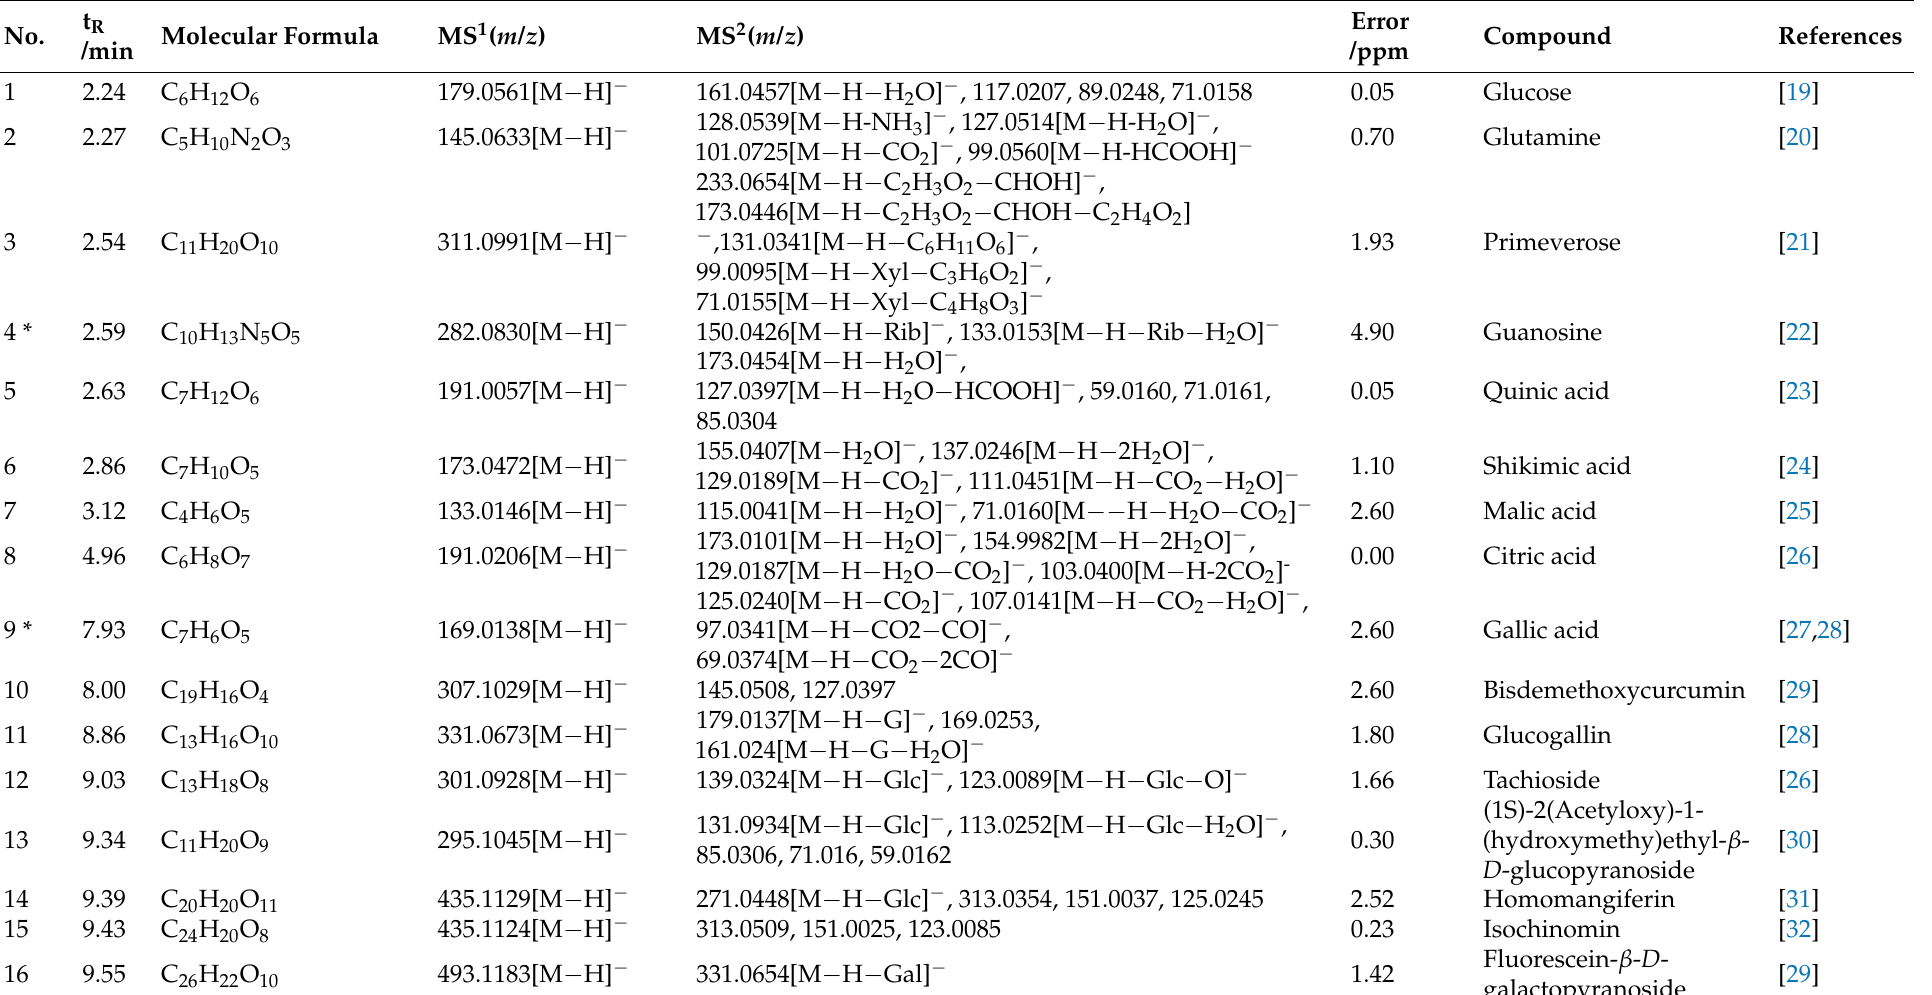
Table 1. Identification of 73 constituents in Taxilli Herba from Morus alba L. by UFLC-Triple